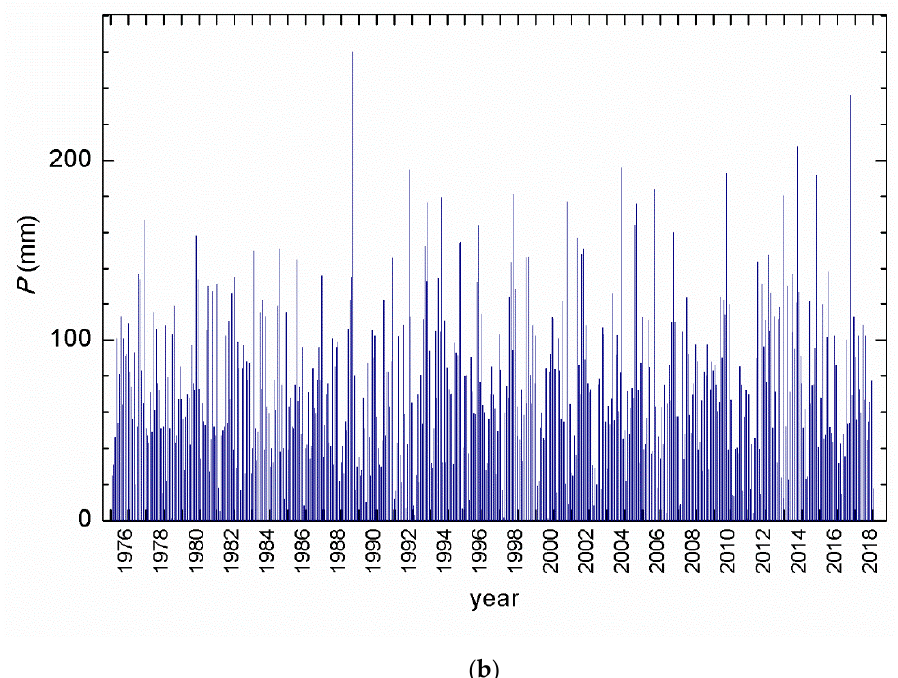
Figure 2. ( a ) Mean monthly air temperatures; ( b ) monthly precipitation amount. Data from station Zagreb–Gri č for the 1976–2018 period. Data obtained from the Croatian Meteorological and Hydrological Service (CMHS). Table 1. Mean annual temperature T , ranges of monthly temperatures within a year, annual precipitation amount P, weighted mean (w.m.) annual δ 18 O, δ 2 H, d -excess ( d ), and the mean annual tritium activity concentration A in precipitation at Zagreb, 1976–2018. Here, n : number of monthly datapoints; % P : percentage of precipitation if different from 100%, comprised by δ 18 O, δ 2 H, and d - excess data; TU: tritium unit. Bold font: the lowest and highest values in a series.